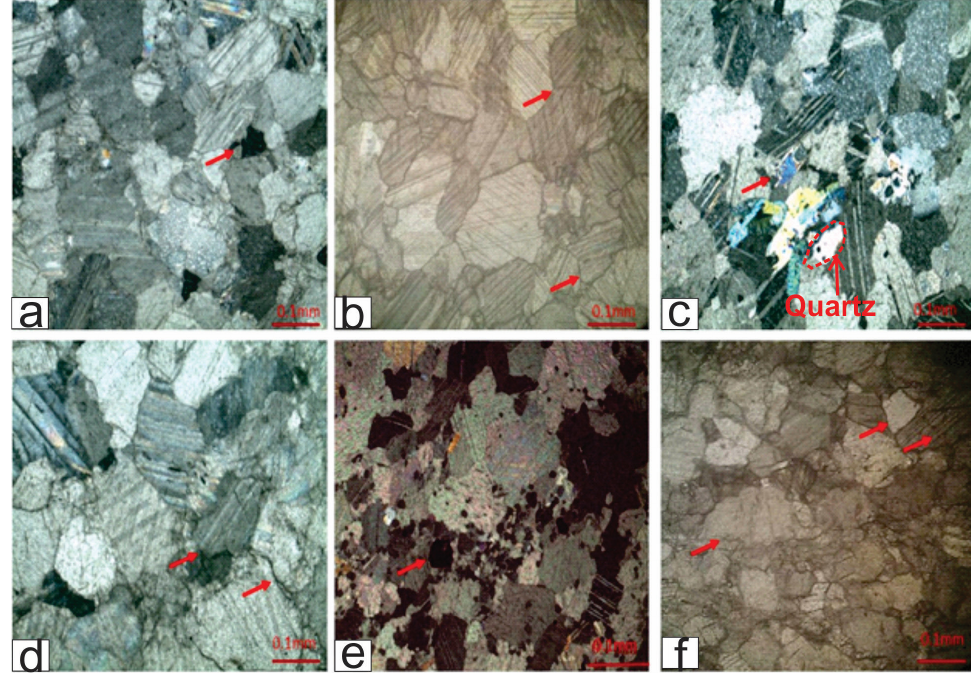
Figure 4. ( a ) Presence of ore minerals (Fe-oxides) with large number of calcite grains GMC1, ( b ) the calcite grain showing twin lamellae GMG1 showing minor fractures in calcite crystal. ( c ) Presence of mica (muscovite, phlogopite, and chlorite) among the calcite grains GMGG1, ( d ) the calcite grain showing invisible twin lamellae GMGz1, ( e ) presence of opaque minerals (Fe-oxides) as a minor mineral with large number of calcite grains showing homoplastic texture GMD1, ( f ) the boundary of calcite grains strongly sutured and an individual calcite grain slightly recrystallized with quartz grain GMA1 . Table 1. Modal mineralogy (Vol. %) of Gahirat Marble.